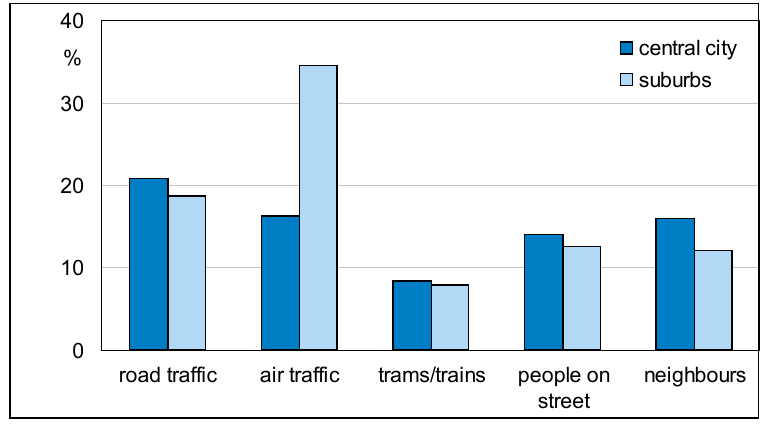
Figure 5. Percentage of respondents annoyed or disturbed at home by different noise